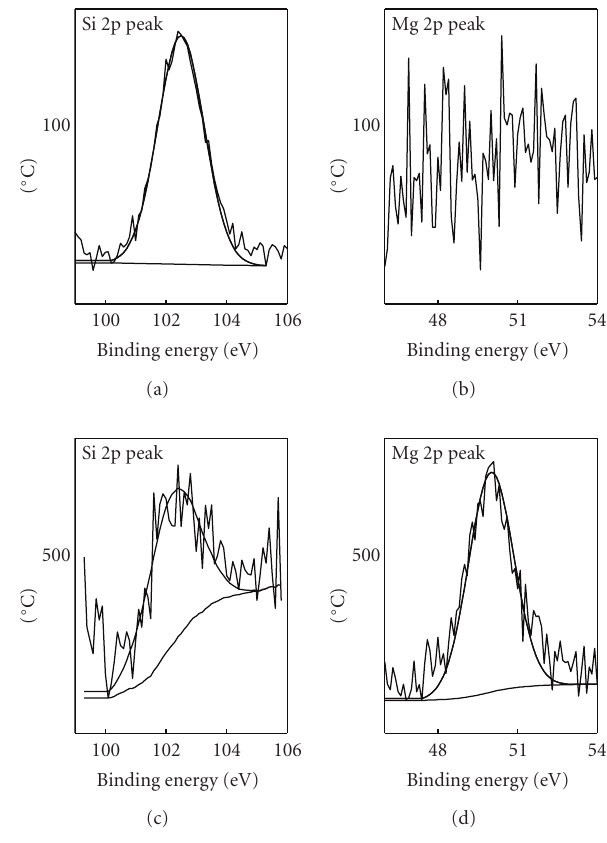
Figure 2: E ff ect of temperature on weakening of the Si signal and appearance of the Mg signal on the untreated A361